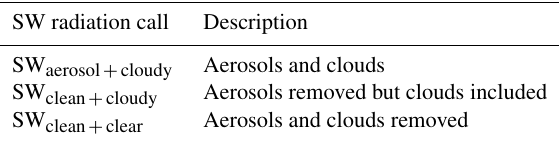
Table 1. Details about the aerosol and clouds that are used in the three calls to the radiation scheme performed on each time